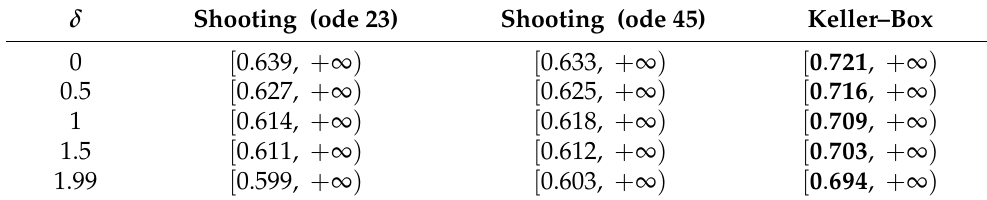
Table 7. Ranges of θλ 2 ensuring convergence without ghost solutions (shooting and Keller–Box procedures).